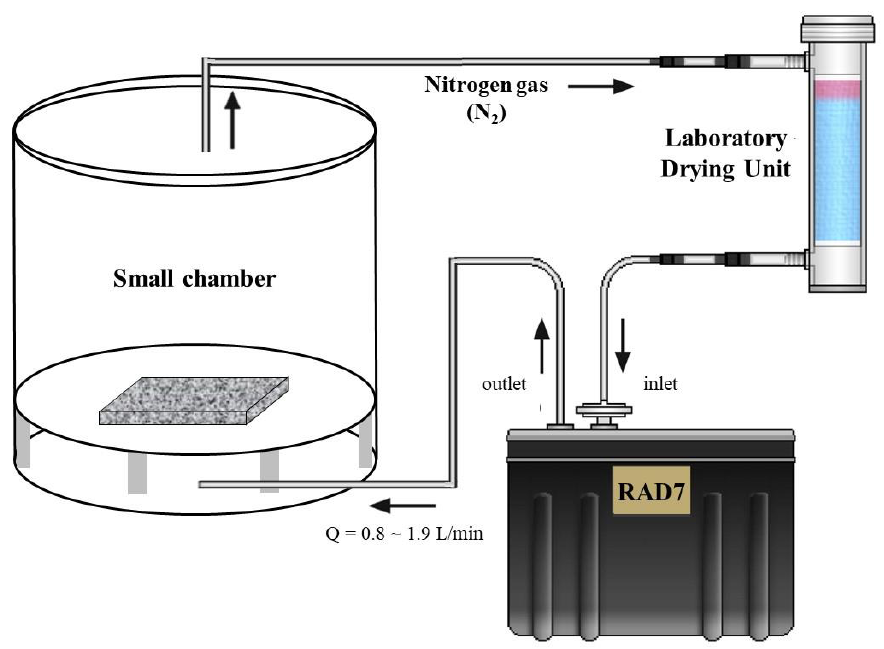
Figure 1. The experiment system used to assess 222 Rn exhalation rates from building materials.